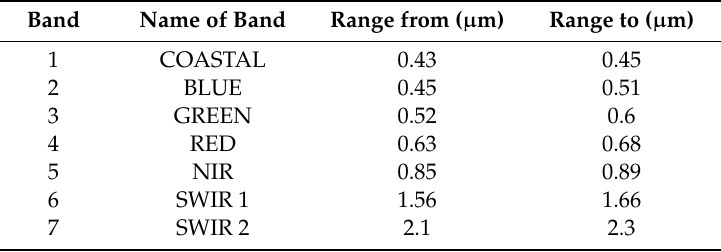
Table 2. Spectral bands of Landsat